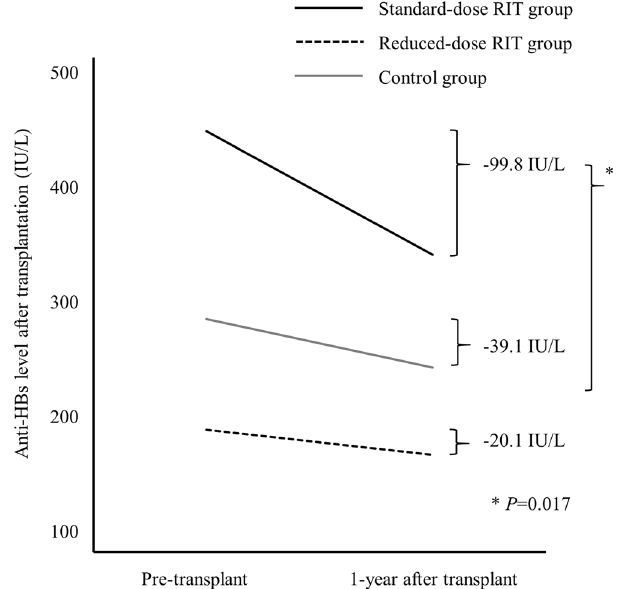
Figure 3. Changes of anti-HBs titer according to rituximab